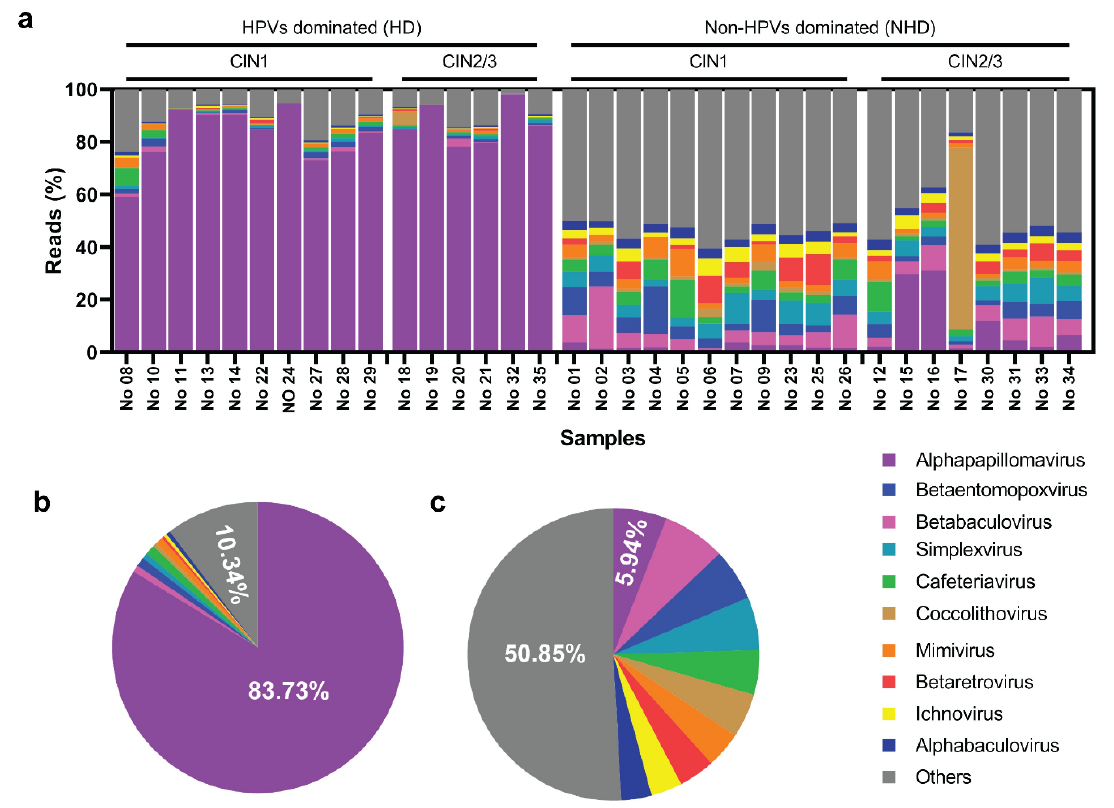
Figure 1. Global taxonomic pattern of viral abundance for the dominant genera in the cervix. ( a ) The percentage of viral reads in each cervical sample, HPV-dominated (HD; left) and non-HPV-dominated (NHD; right). ( b , c ) Pie graph representing the means of viral reads (%) in HD and NHD groups.